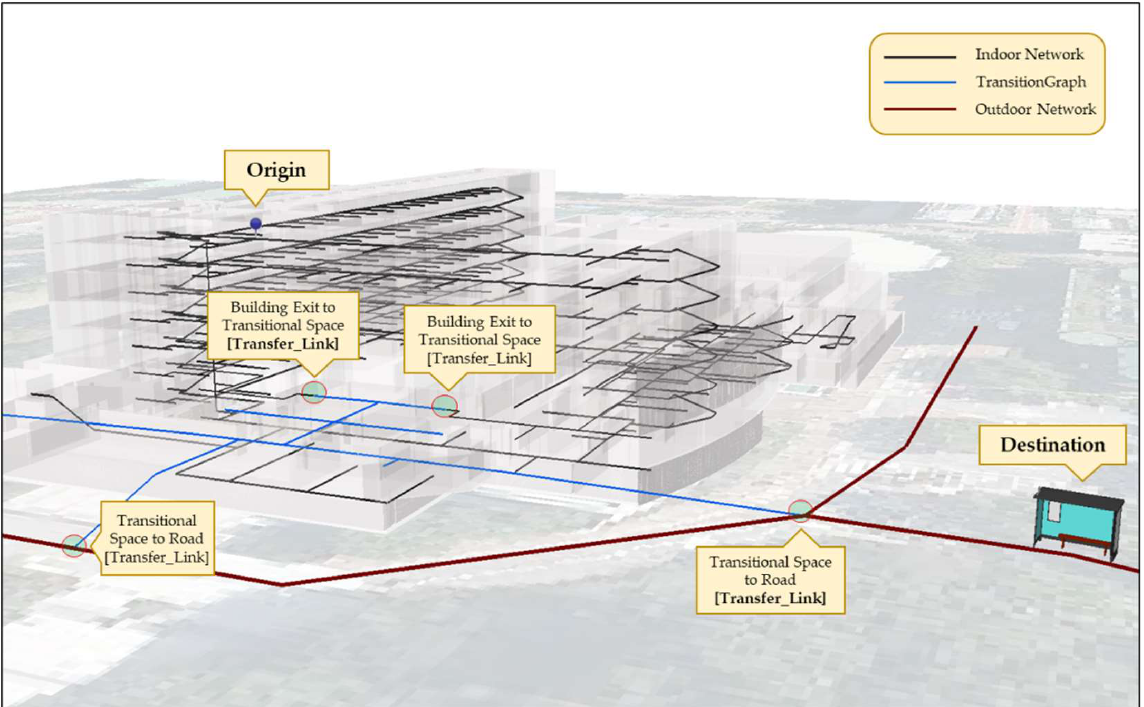
Figure 12. Generating the transition graph for the ( a ) SeamlessNavigation extension module and ( b ) proposed model.